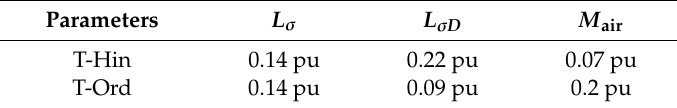
Table 1. The comparison of the three